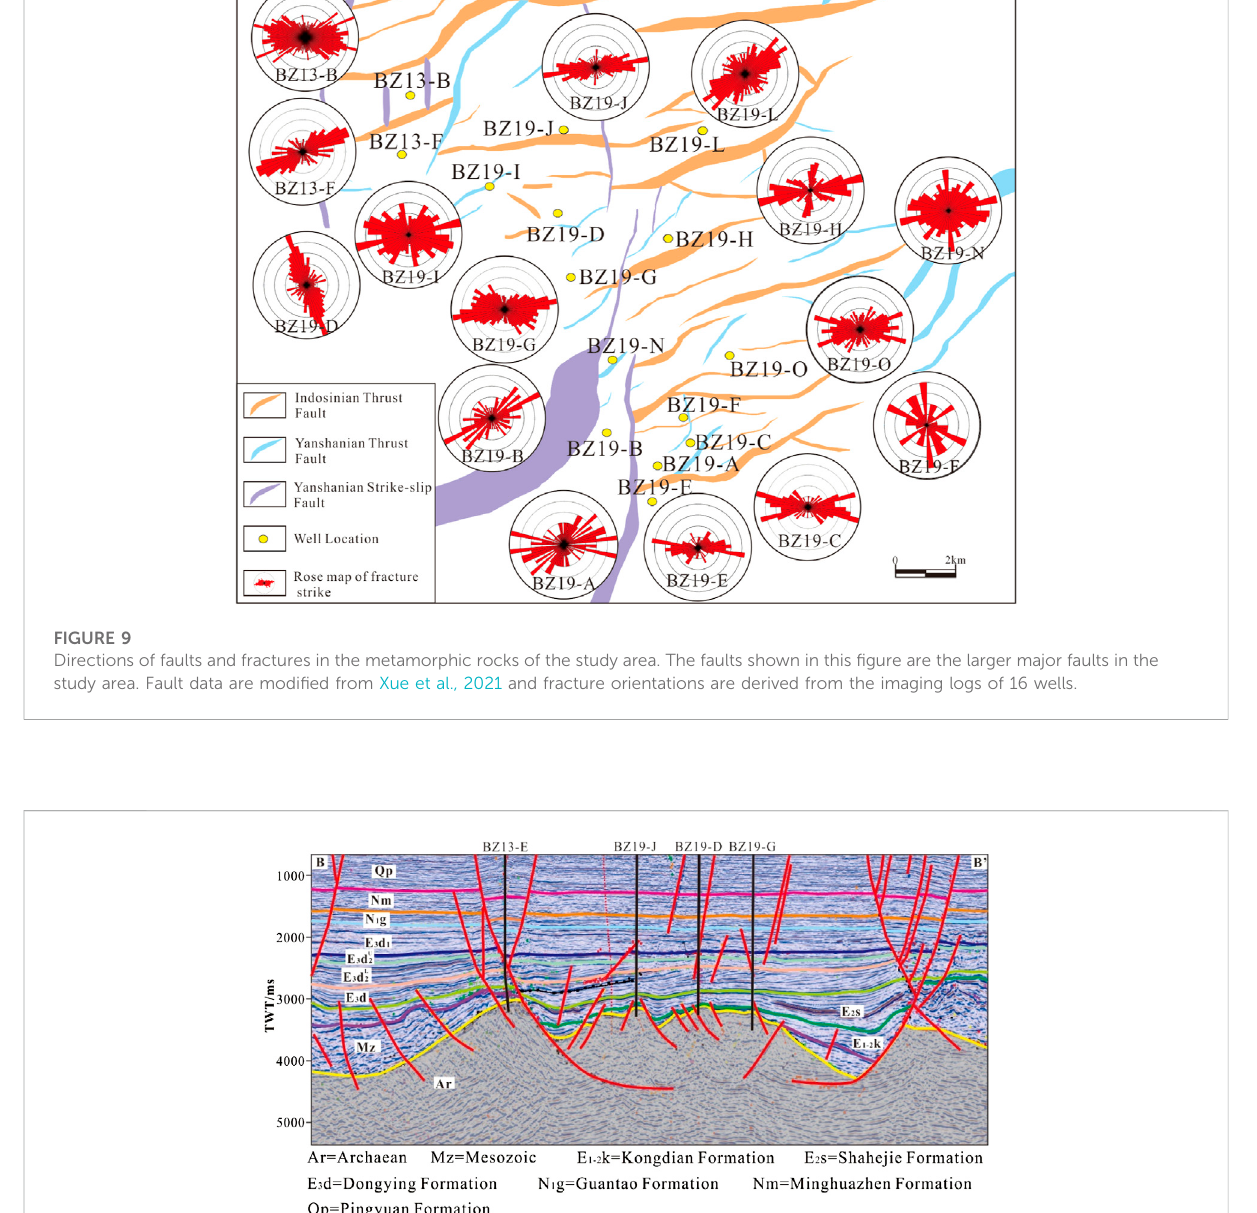
Frontiers in Earth